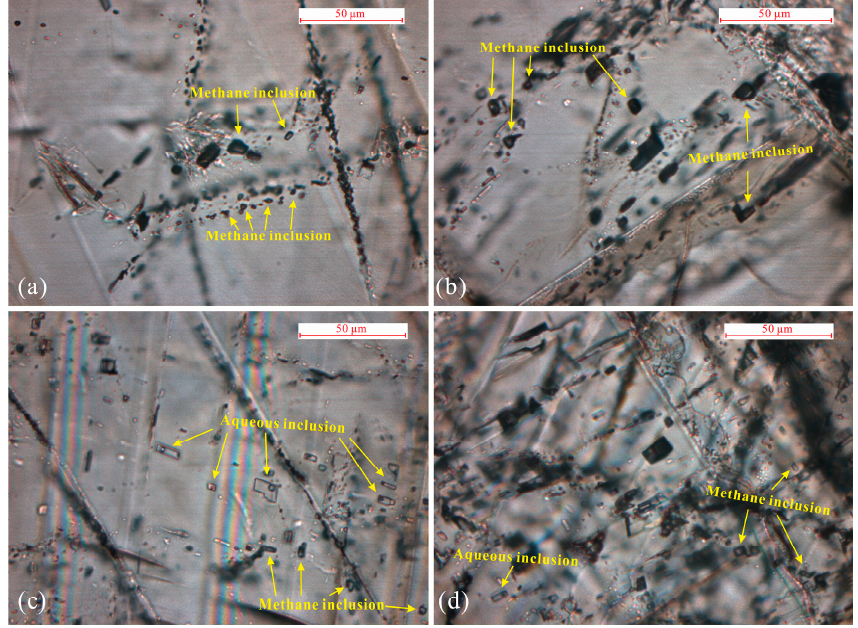
Figure 5. Occurrences and morphologies of representative methane inclusions ( a , b ) and aqueous inclusions ( c , d ) in fibrous calcite veins within the Mbr 1 1 of Longmaxi Fm shale of well H-2, Southern Sichuan Basin.